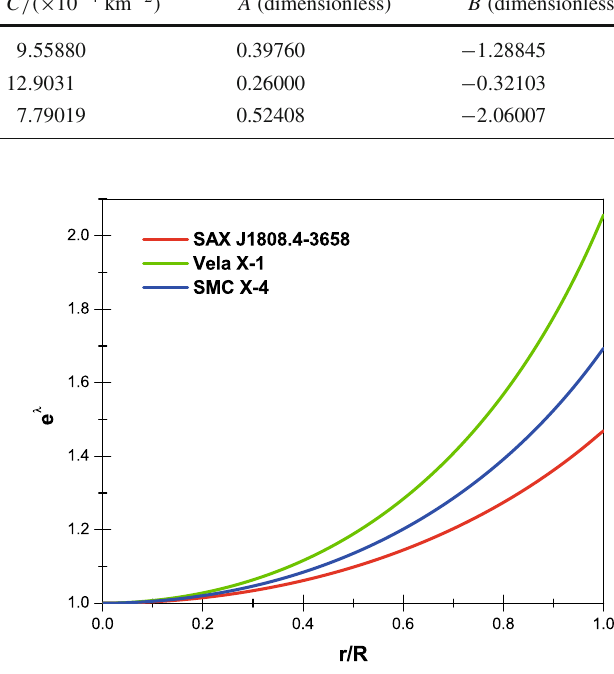
Fig. 3 The temporal metric component versus the dimensionless radius for α = 0 . 3